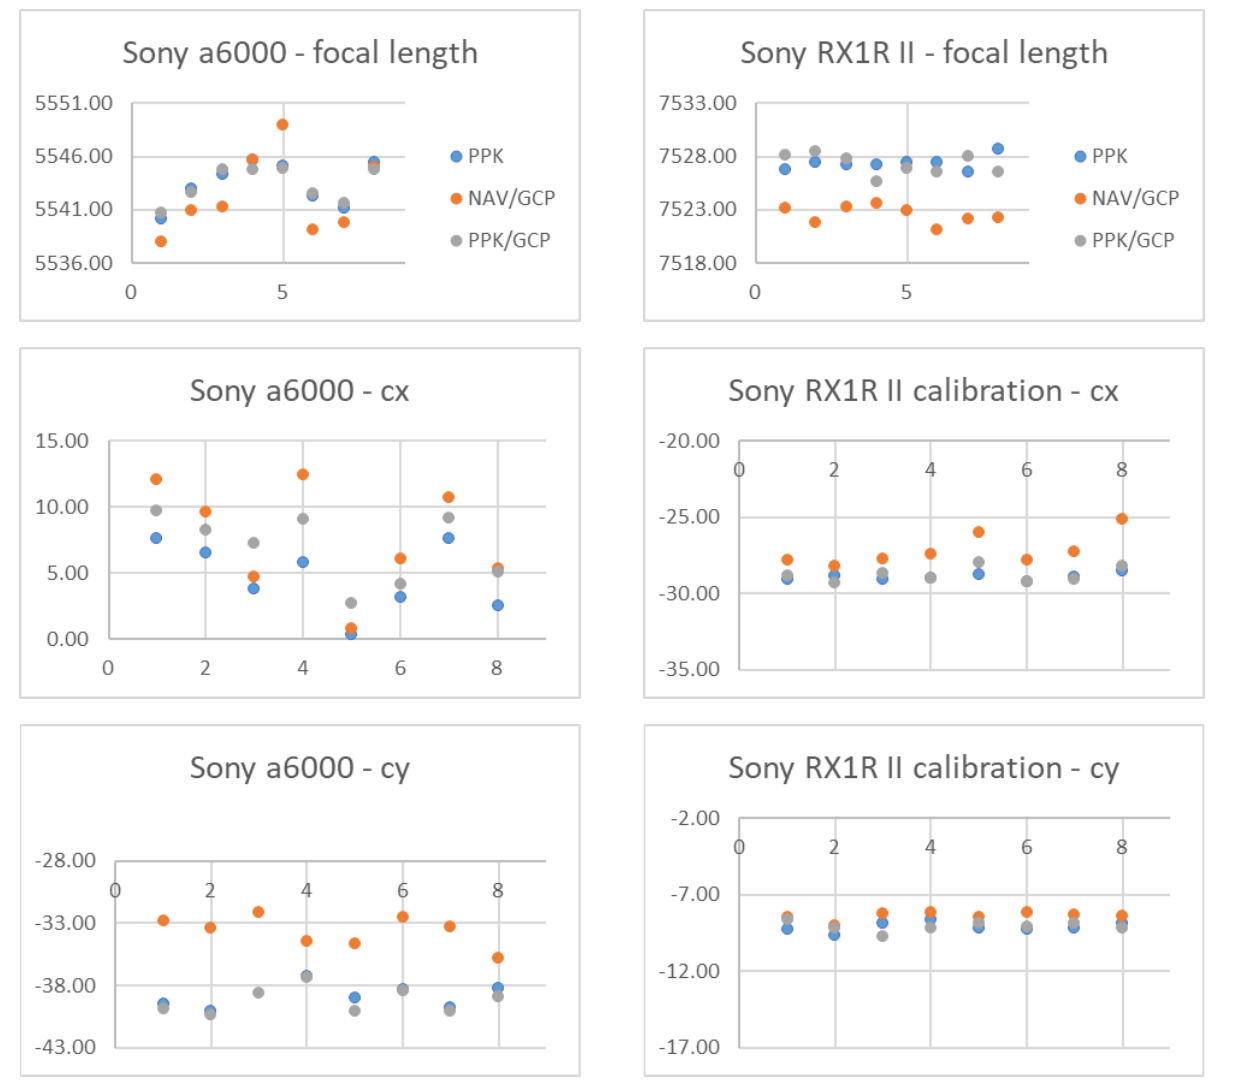
Figure 6 Sony a6000 in - situ calibration values Figure 7 Sony RX1R II in - situ calibration